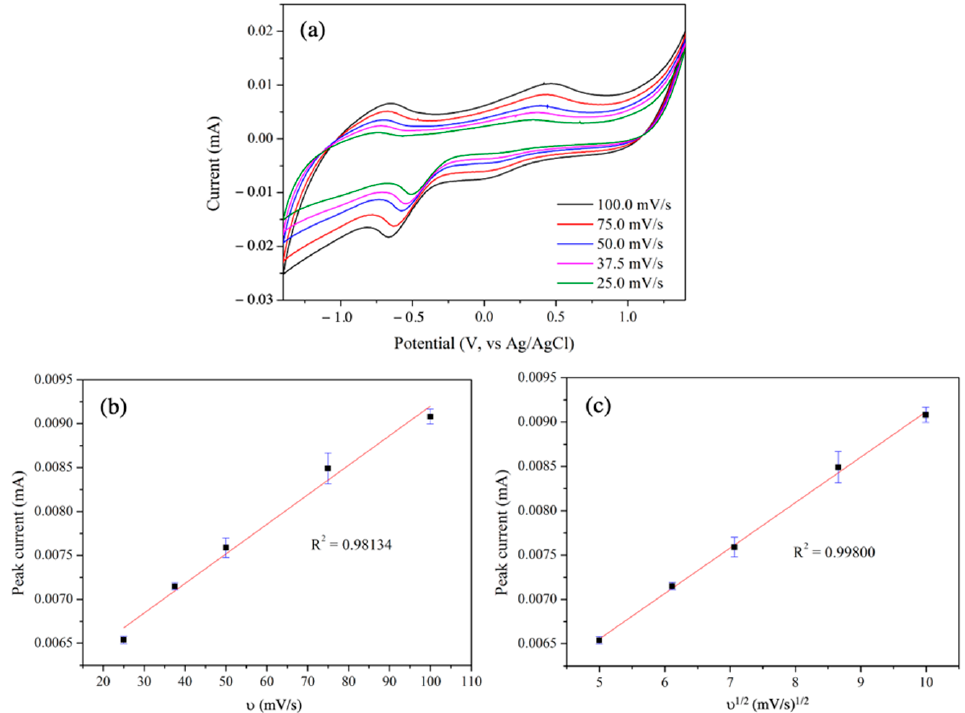
Figure 7. ( a ) Cyclic voltammogram of the BaTiO 3 /MWCNT composite (2:1)-based electrode at scan rates of 25–100.0 mV/s, ( b ) relation between the peak current and scan rate of reduction reactions, and ( c ) relation between the peak current and square root of the scan rate of reduction reactions in 500 µM citric acid.